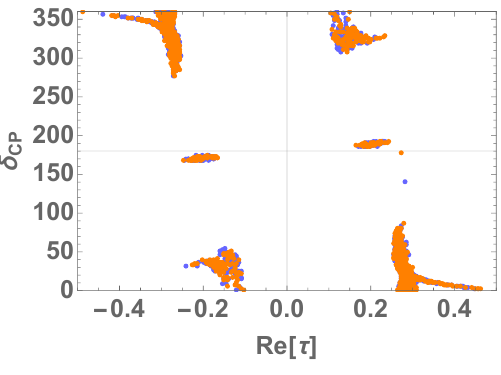
Figure 8 . Predictive δ CP versus Re[ τ ] . Blue color points (negative Y B ) almost overlap with orange ones (positive Y B ). Points correspond p p to the output of section 4 at χ 2 ≤ χ 2 ≤ 3